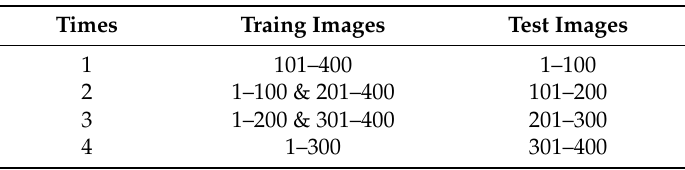
Table 2. Procedure for using